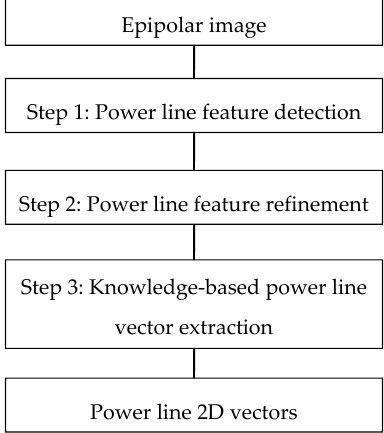
Figure 4. Flow chart of power line 2D vector extraction.